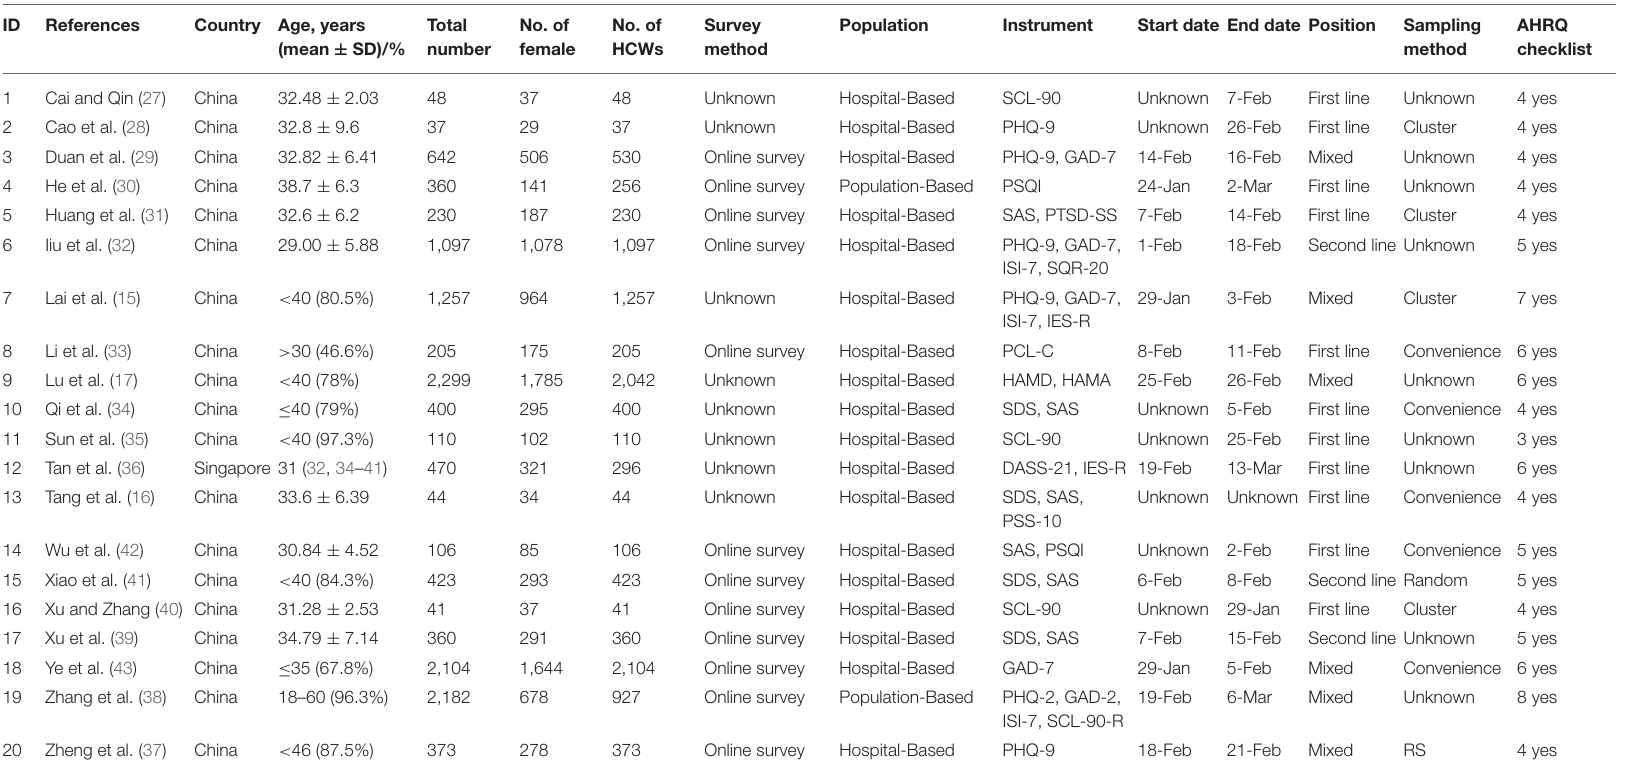
TABLE 1 | Characteristics of the included studies in this systematic review and